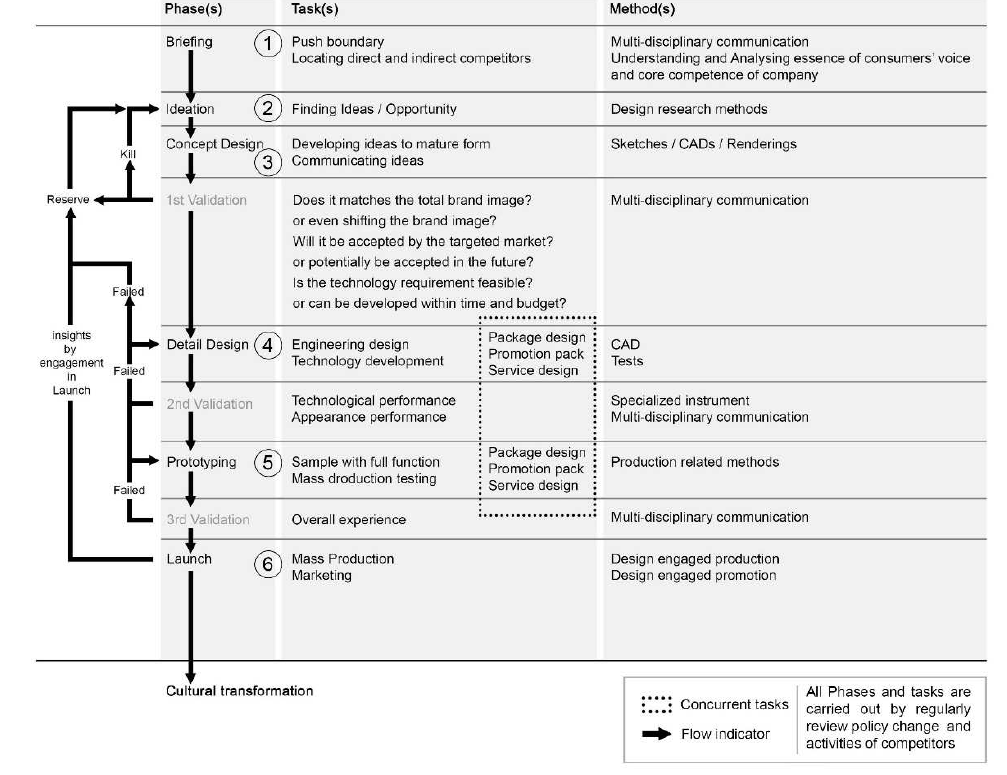
Figure 1: Conceptual Designer-led NPD Process Model (Lou et al.,